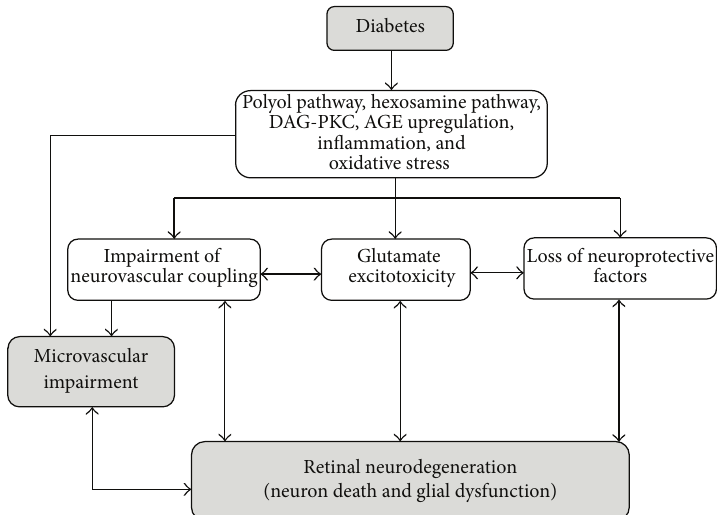
Figure 2: Potential therapeutic targets based on pathogenic mechanisms involved in retinal neurodegeneration induced by